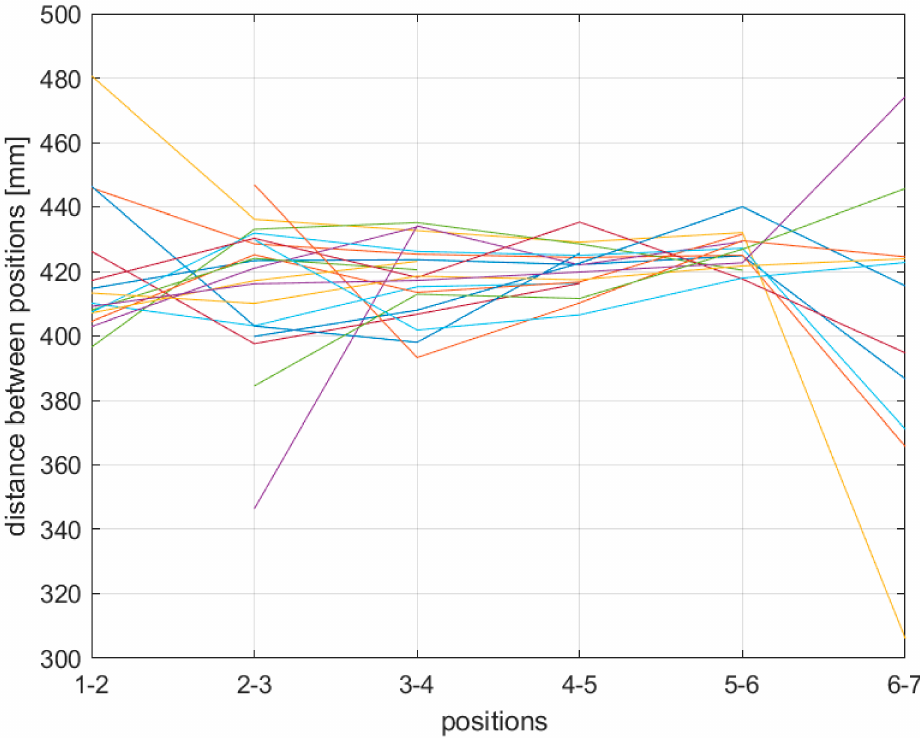
Figure 14. Body joint relative accuracy measurements of Kinect v1 with skeleton smoothing turned